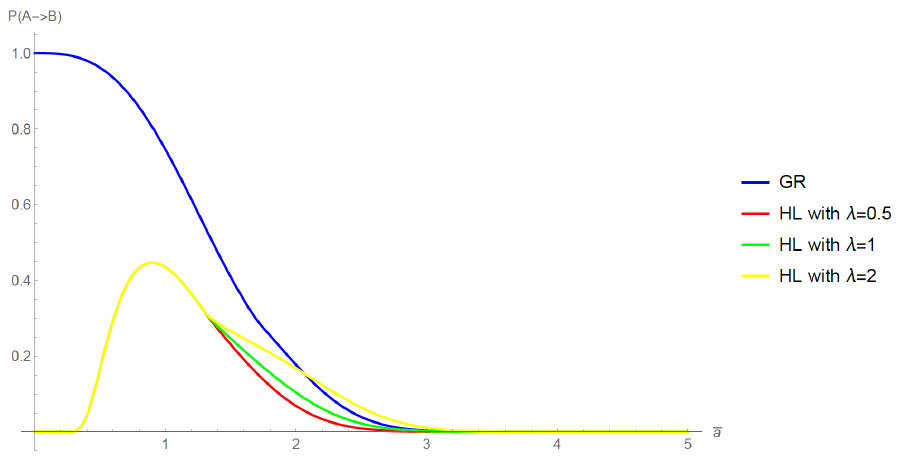
= 1, with V = V A = 1, V = V B = 0.1, Figure 1. Transition probability in units such that 24 π 2 B A 0 0 ¯ h = 2, c = c = c = 1, for GR (blue line) and = α A = α A = 5, α B = α B = α B = 4, T = T α A 0 2 T 2 3 T 3 1 T 1 2 3 2 3 1 1 HL with a scalar field depending on all spacetime variables with λ = 0.5 (red line), λ = 1 (green line) and λ = 2 (yellow line). For HL we choose a 0 = 0.000001 but the same form is expected for a 0 =